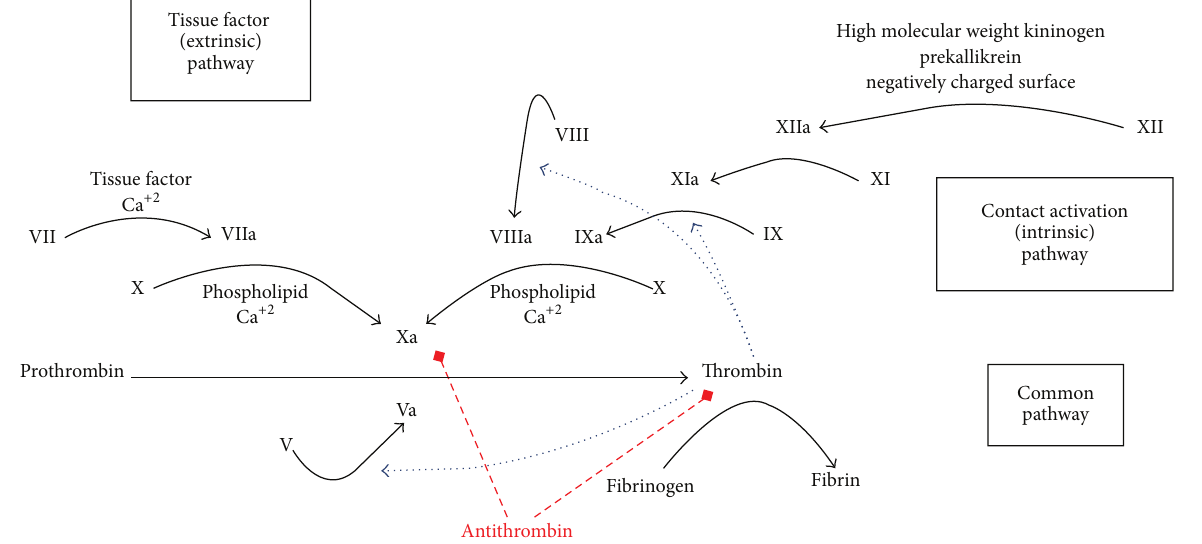
Figure 1: Coagulation